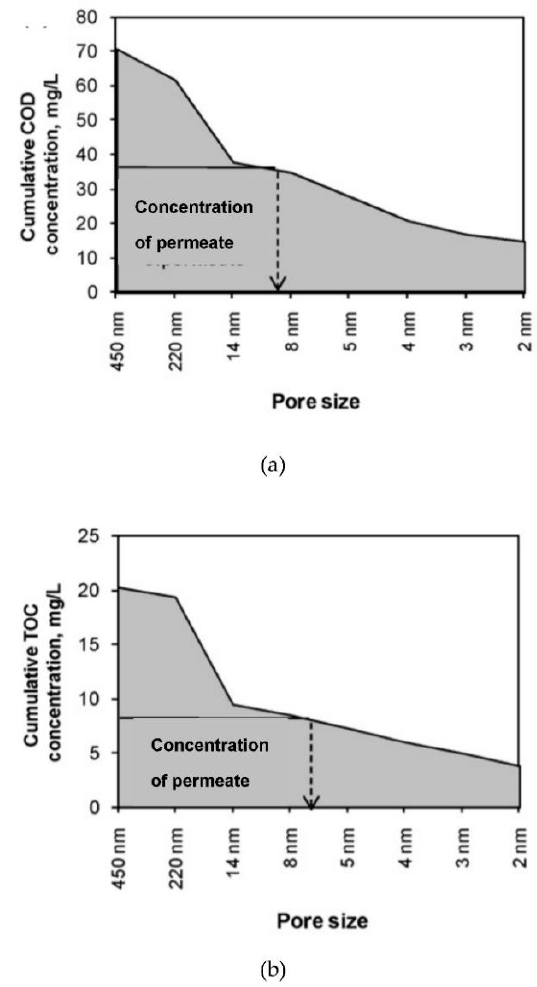
Figure 2. Cumulative size distribution for soluble COD indicating the effective filtration size [21]